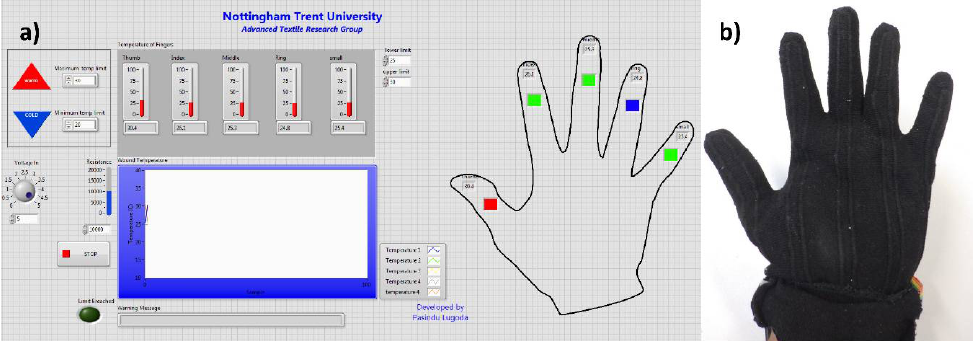
Figure 2. Prototype temperature sensing glove. ( a ) The LabVIEW software user interface for the glove. ( b ) A photograph of the prototype glove.